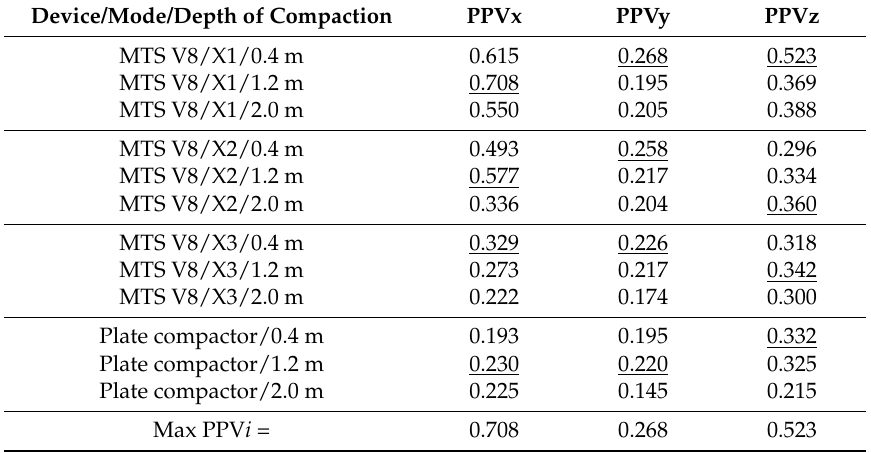
Table 5. Peak component particle velocities at the foundation wall of the building—stage I, mm/s.